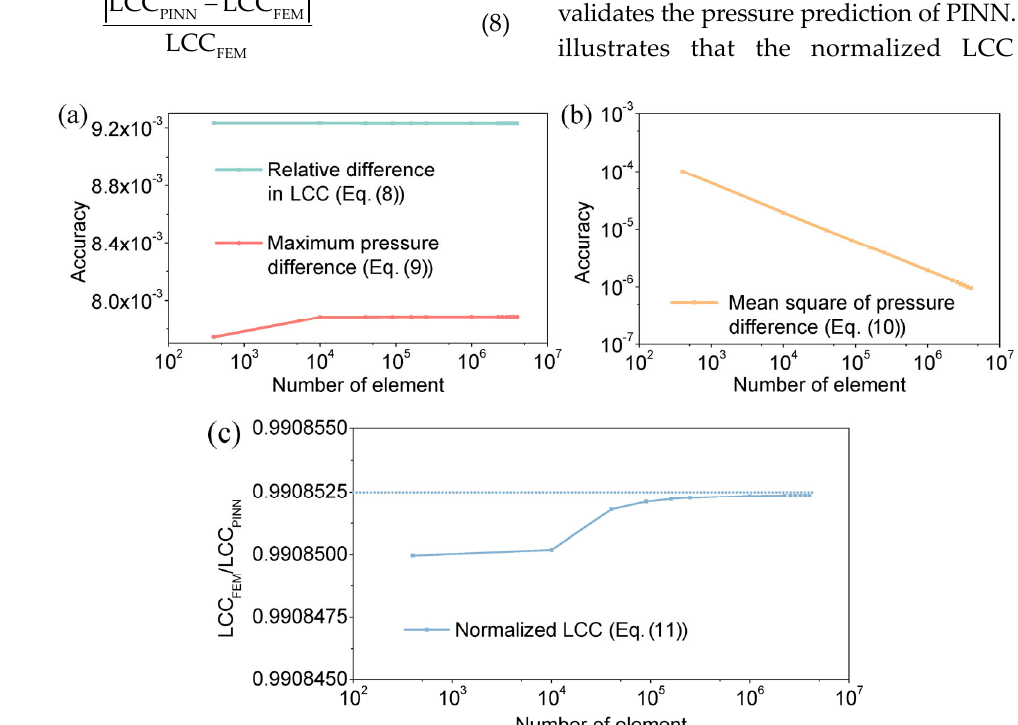
Fig. 11 Comparison between PINN and